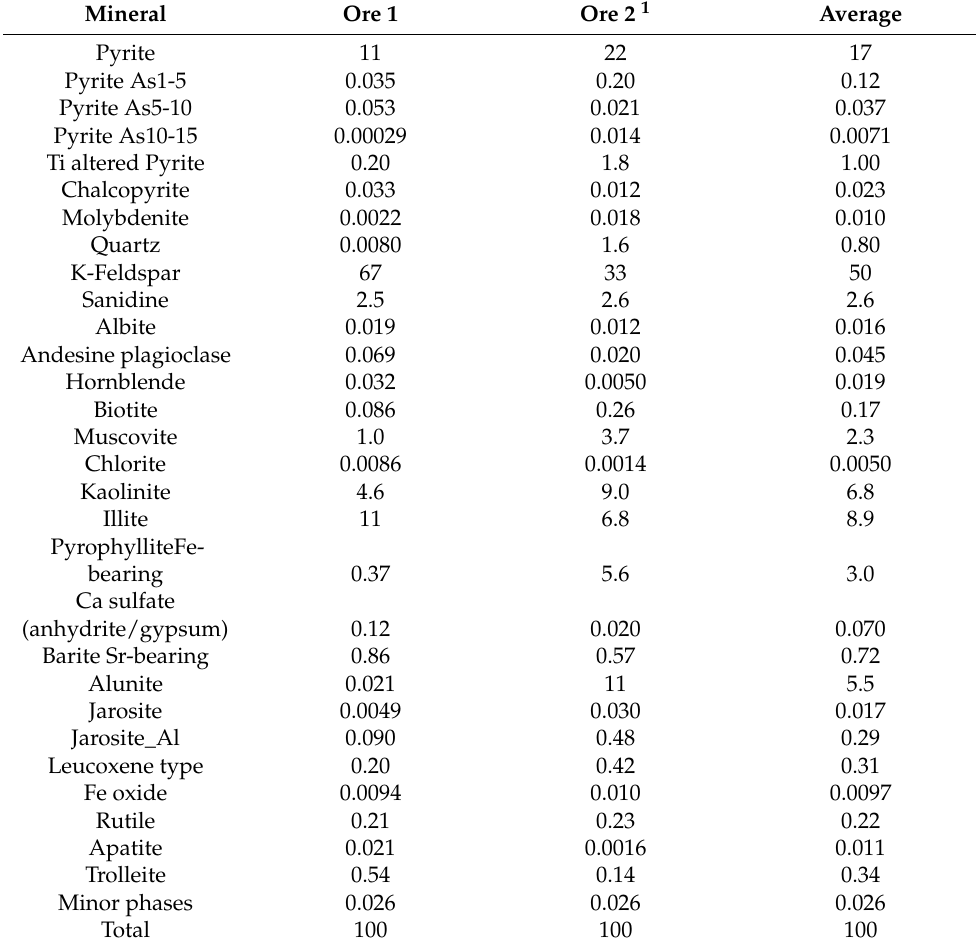
Table 2. MLA data (as mass %) measured on +425/ − 850 micron screened size